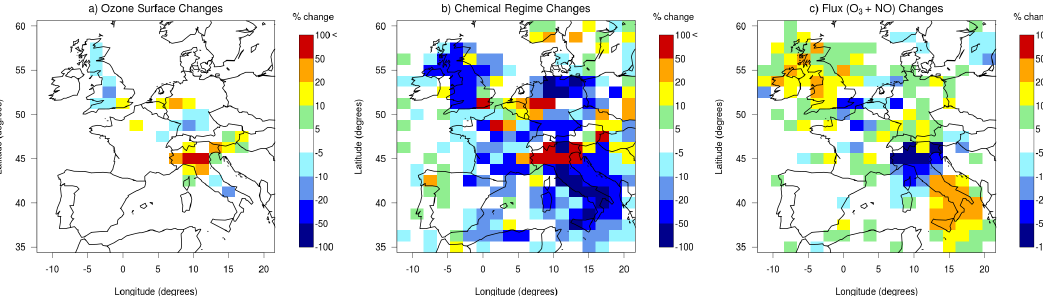
Fig. 3. Summary for Europe of the 100% redistribution run compared to the base run for the month of December. Figures show (a) ozone surface changes; (b) surface chemical regime changes through the ratio of H 2 O 2 : HNO 3 production, where large positive change indicates the regime shifting towards more NO x -limited conditions and large negative change indicates the regime shifting towards more VOC-limited conditions; and (c) surface changes in the removal of O 3 through the reaction flux O 3 + NO. All differences are as percentage change ( redistribution-base base × 100 ).